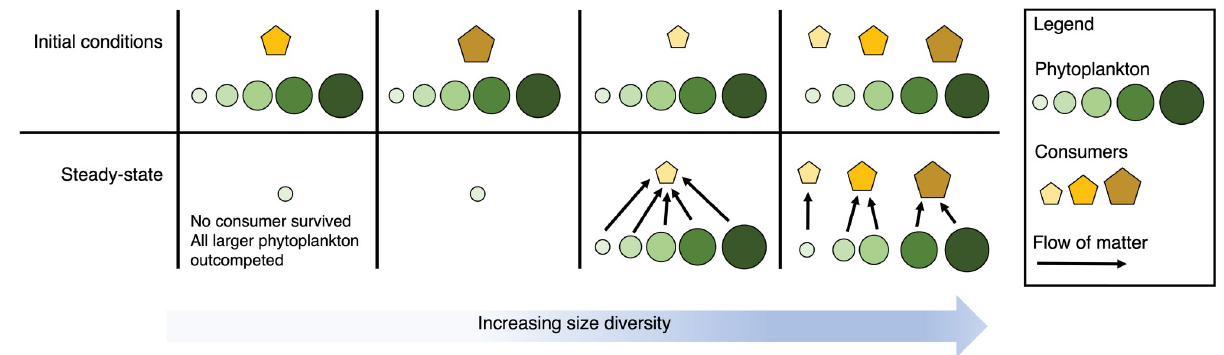
Fig 3. Changes in the size diversity of the planktonic community among four modeled systems, with each of three consumers separately or all together. Initial conditions are in the top panels and steady-state solutions in the bottom panels. A keystone predator effect facilitates competitive abilities of different size classed phytoplankton. The most diverse grazer community supports a diverse phytoplankton community. Sizes of symbols are relative sizes and not to